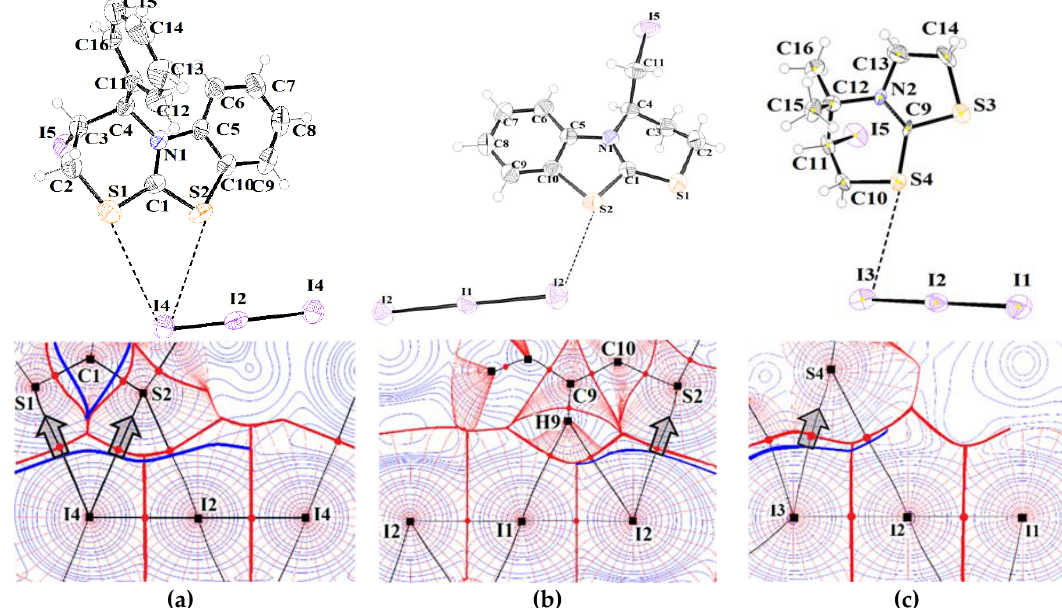
Figure 4. ORTEP diagrams of crystal structures illustrating the typical S ... I chalcogen bond (on top); on bottom: gradient fields, atomic basins and bond critical points of electron density (red lines and points), electrostatic potential distributions (blue lines) for typical chalcogen bonds ( a ) 2a (plane I4—-I2 ... S2); ( b ) 2b (plane I2–I1 ... S2); and ( c ) 2c (plane I3–I2 ...